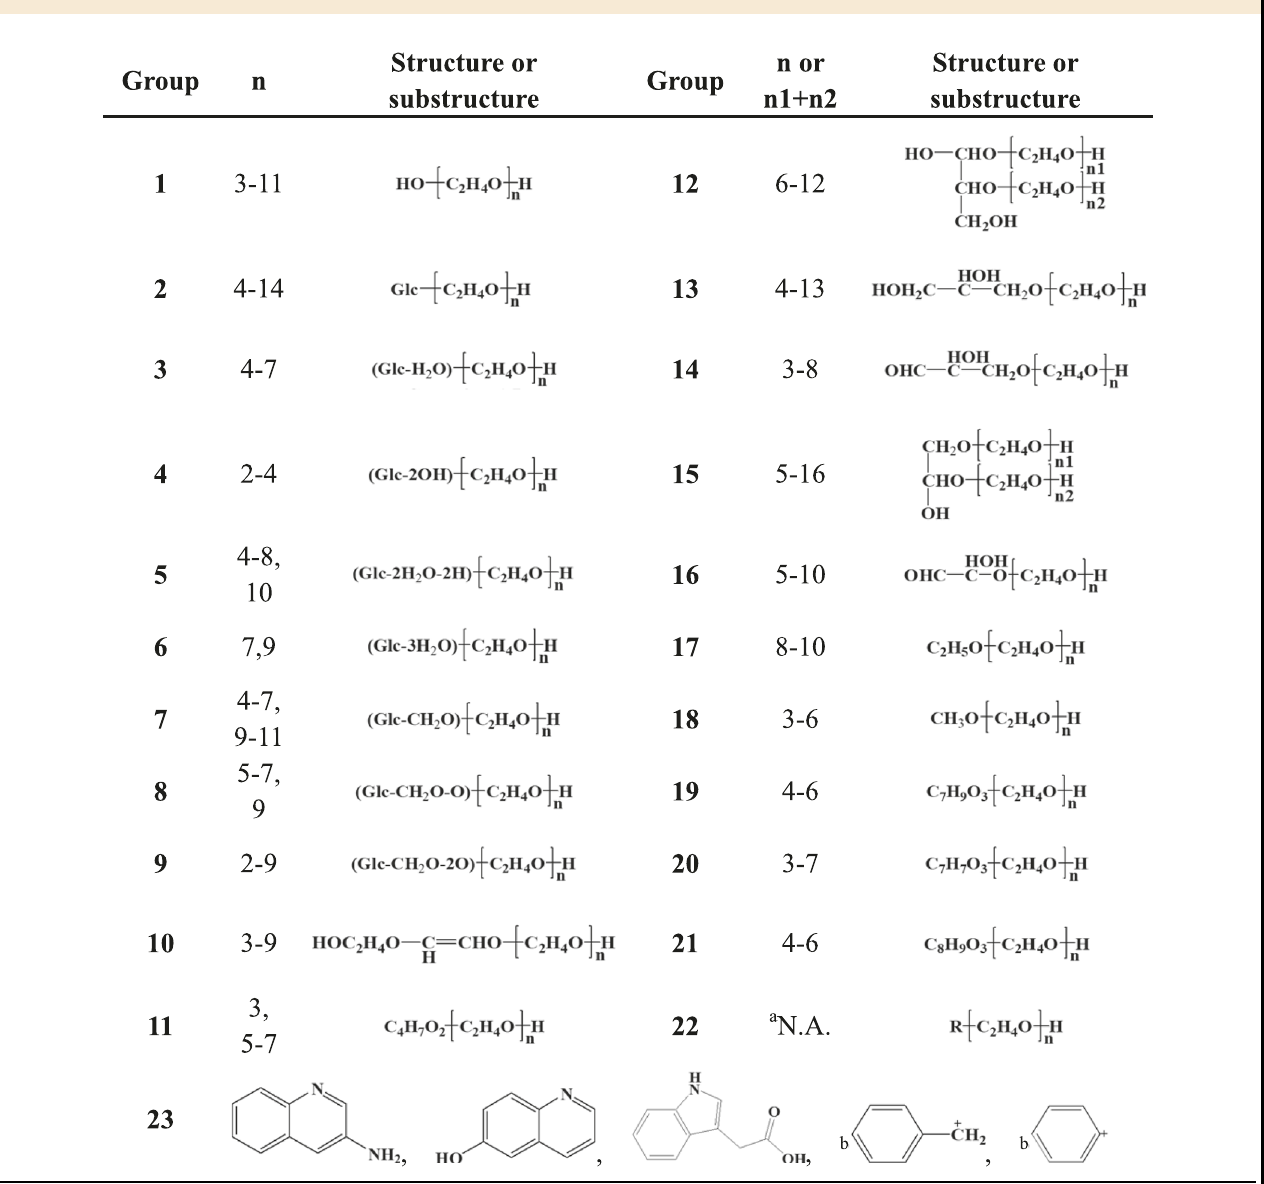
Table 1 Structures or substructures of the identi fi ed photodegradation products from laboratory-synthesized carbon